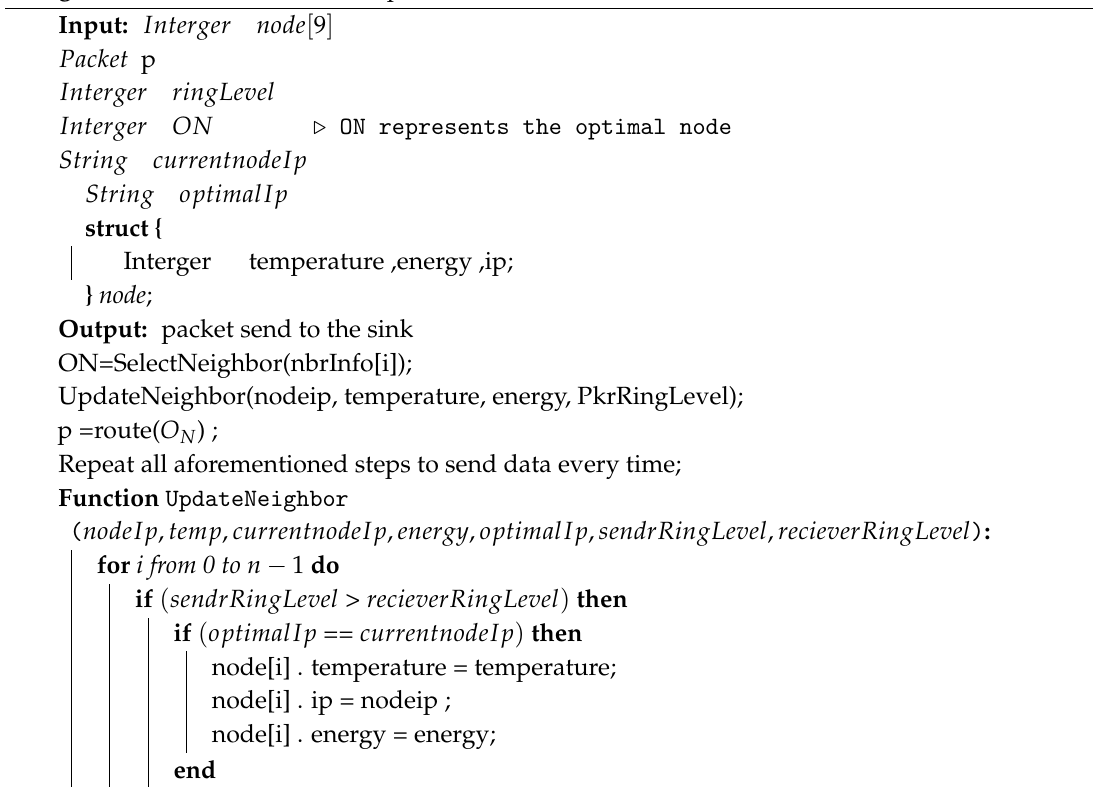
Algorithm 2: Data transmission